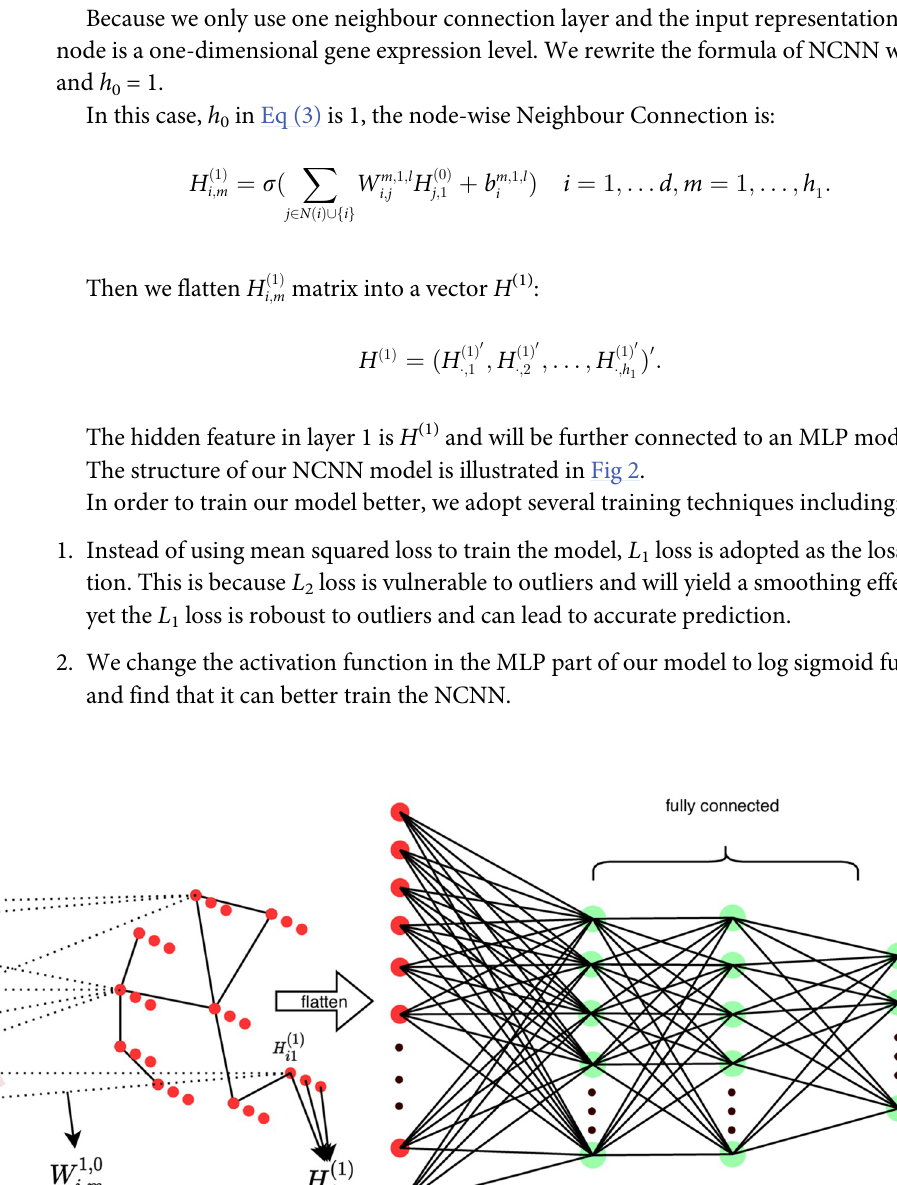
PLOS ONE | https://doi.org/10.1371/journal.pone.0281286 February 6,